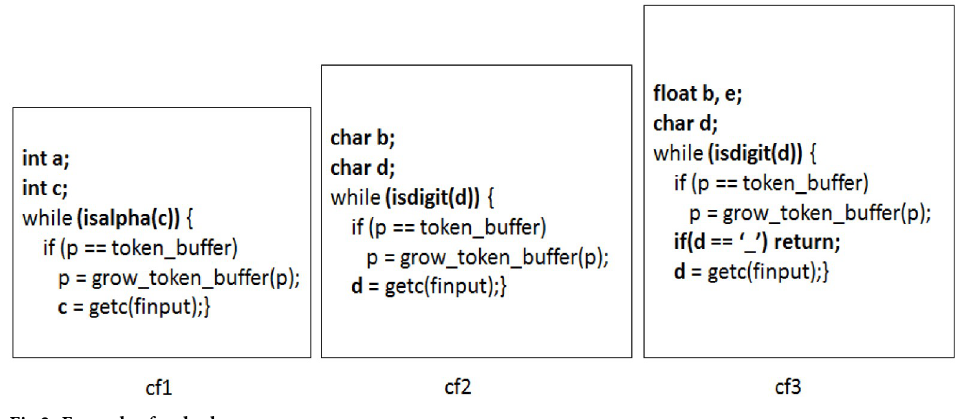
Fig 2. Example of code